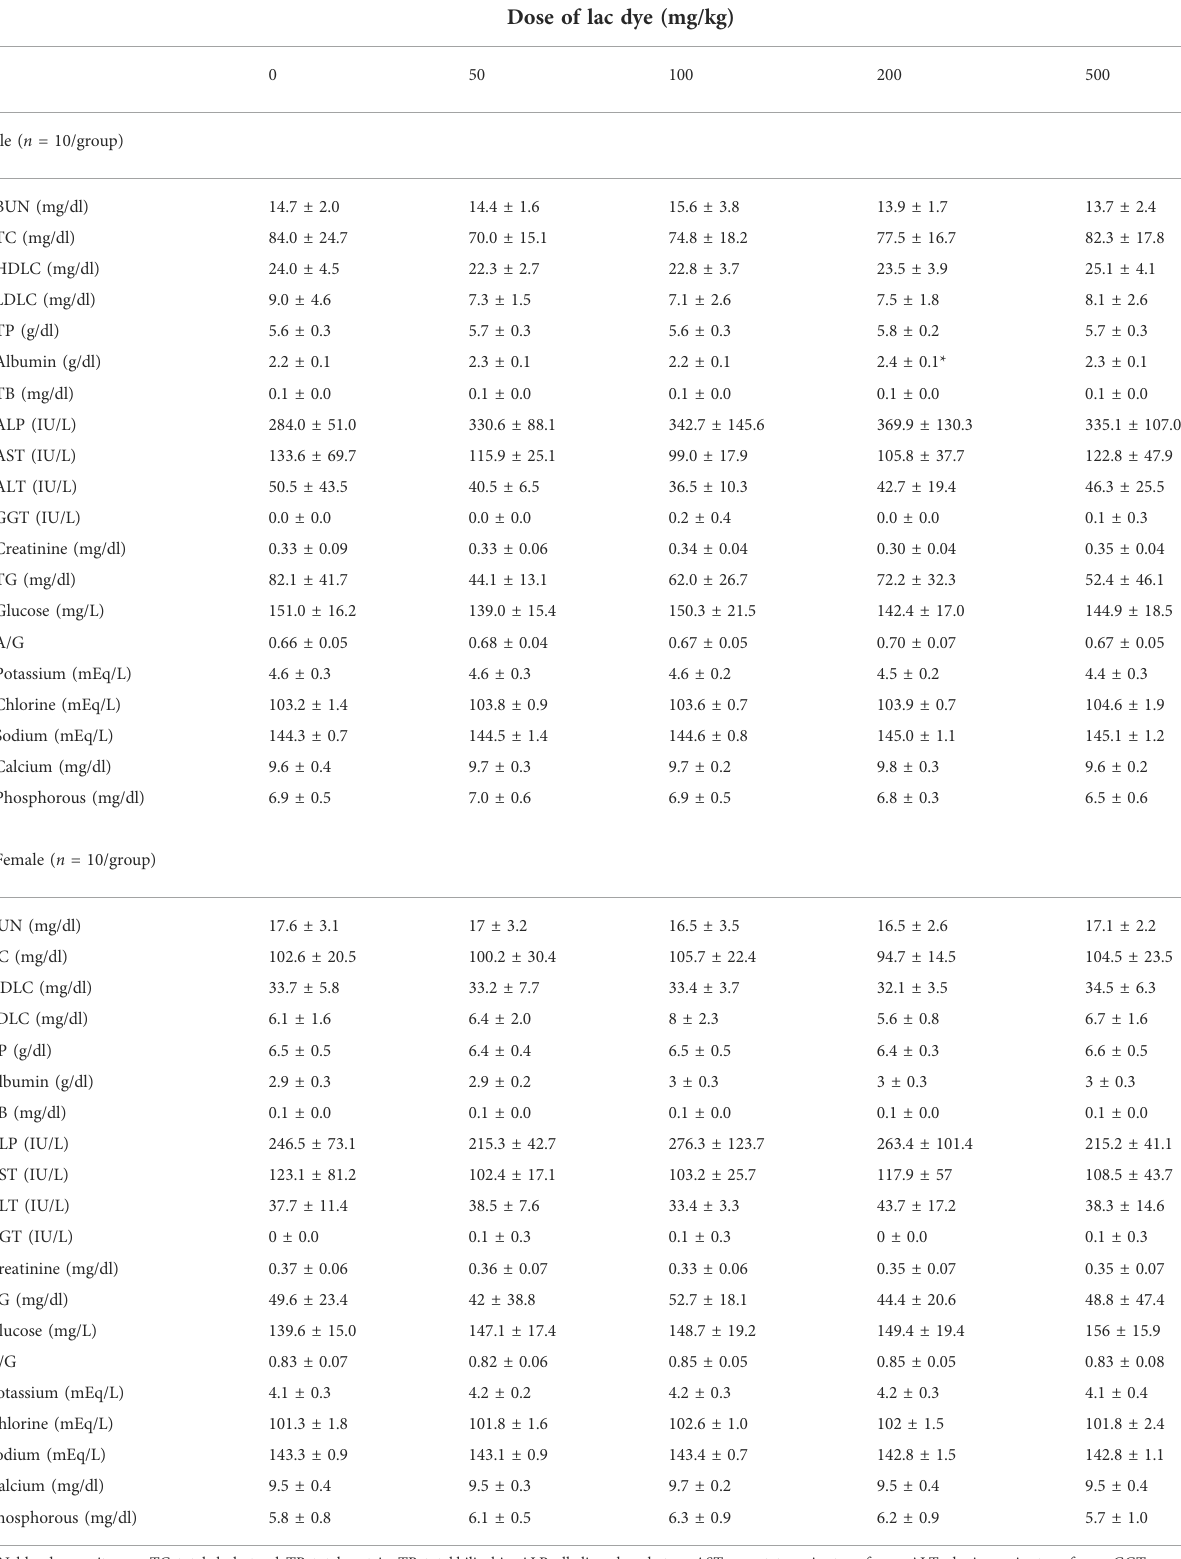
TABLE 2 Serum biochemical parameters of SD rats orally treated with lac dye for 90